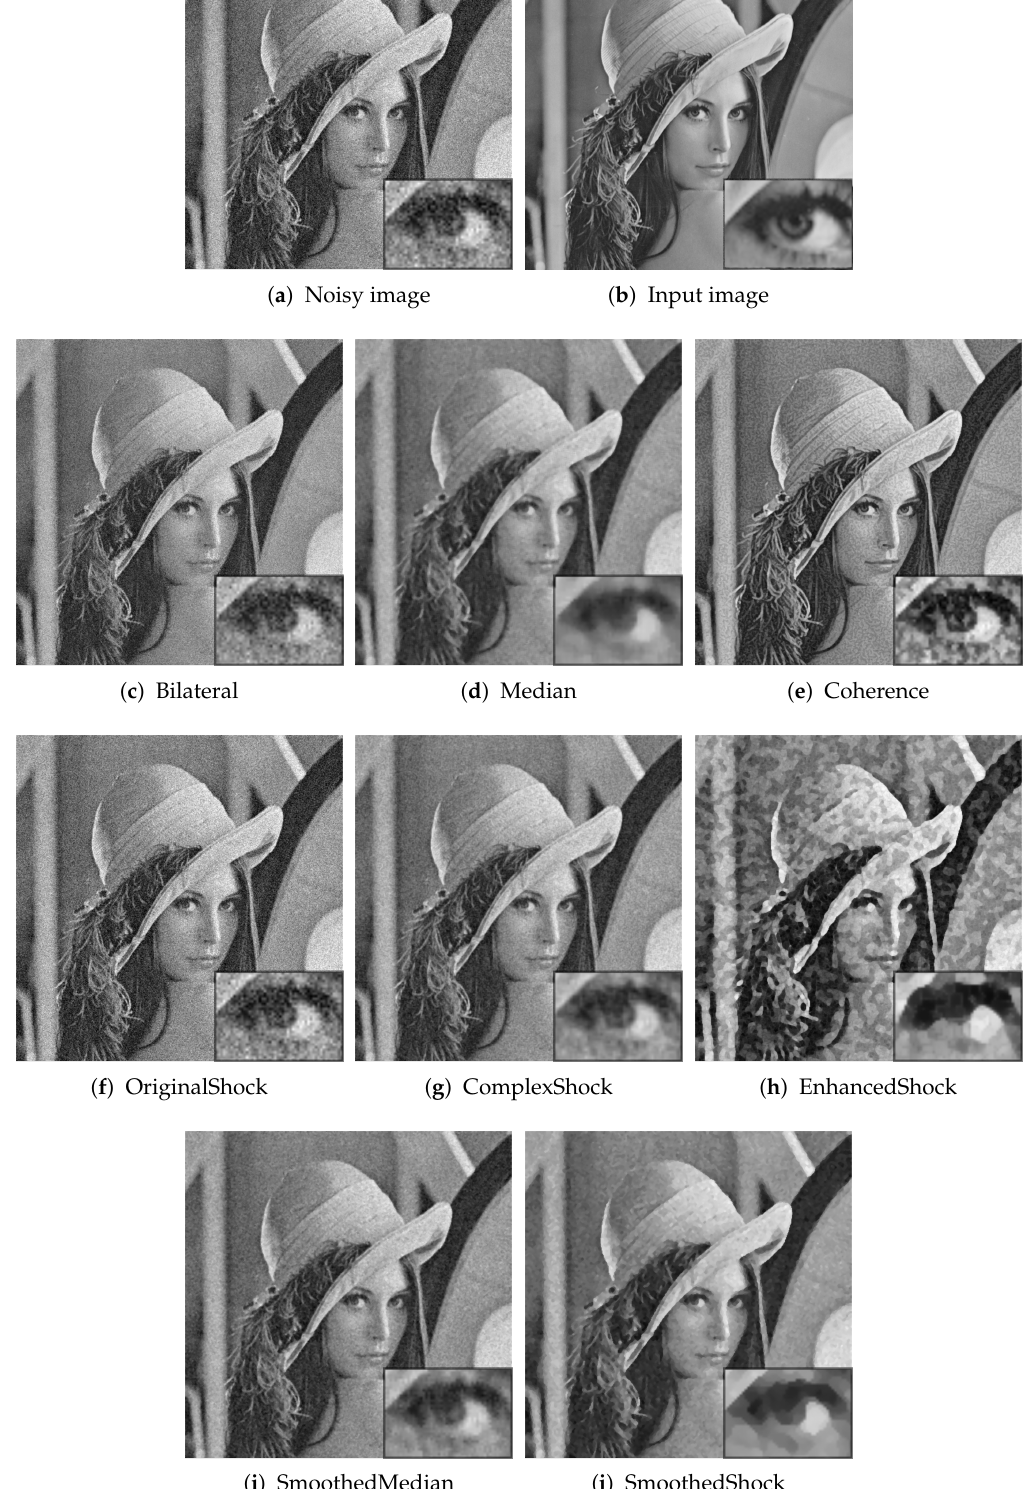
Figure 7. First illustrations of the results obtained for image denoising algorithms of our